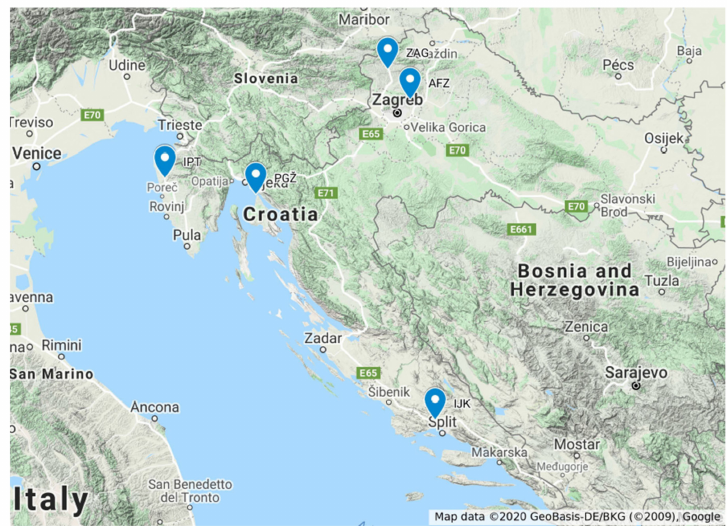
Figure 1. Geographical location and basic information on Croatian grapevine collections: AFZ—National Collection of Autochthonous Varieties, University of Zagreb, Faculty of Agriculture; Experimental station Jazbina, Zagreb; GPS: 45.857860, 16.003847; IJK—Collection of